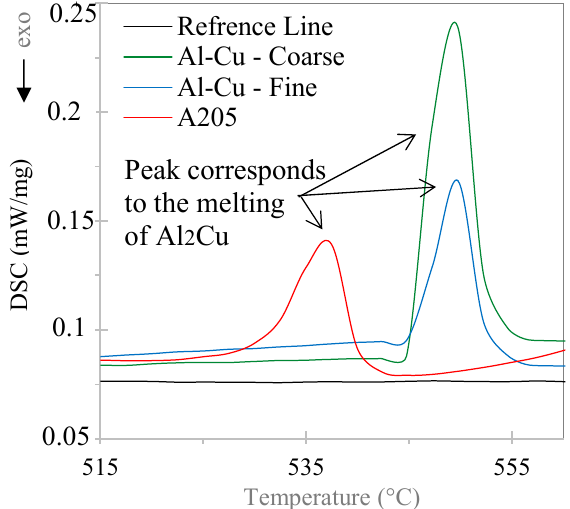
Figure 8. Al 2 Cu melting peaks on the typical differential scanning calorimetry (DSC) heating curves of the as-cast Al-Cu and A205 alloys (the curves are offset for clarity).